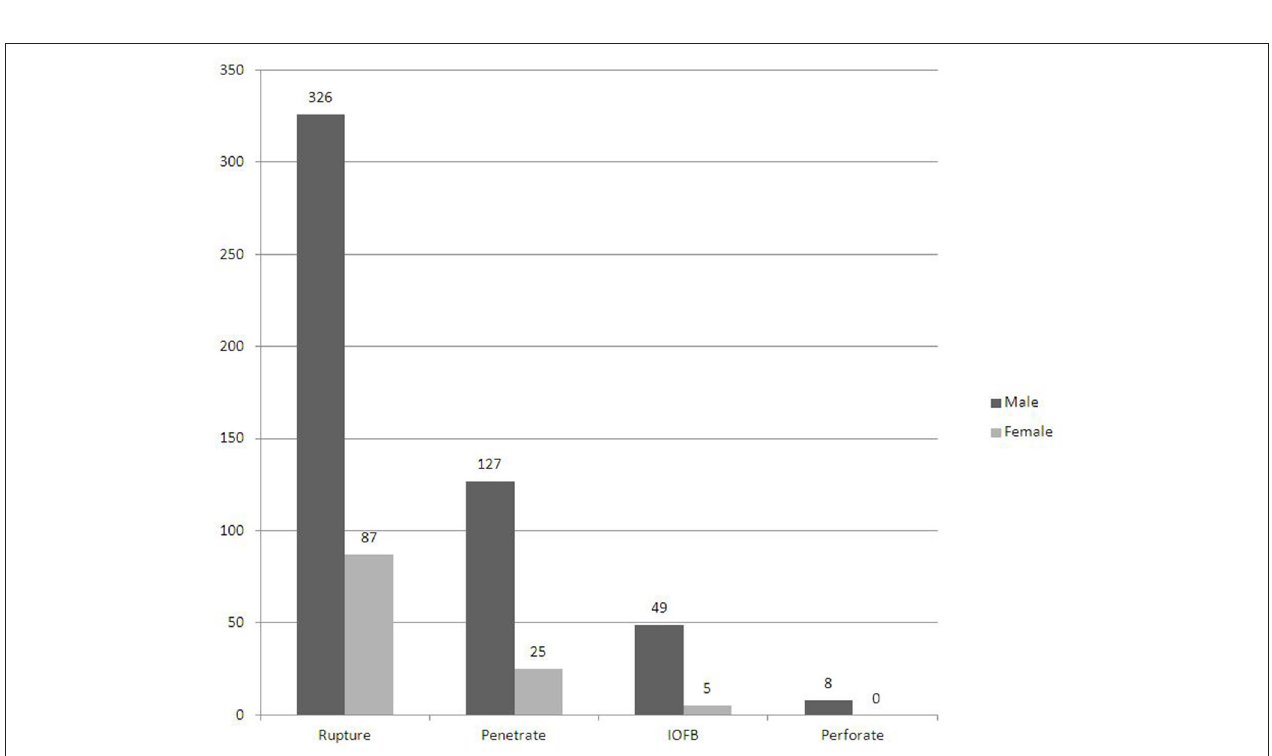
FIGURE 2 | Distribution of gender and types of opened globe injury